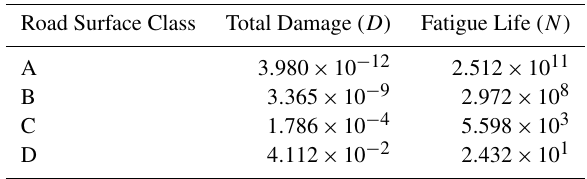
Table 4. Fatigue life of knuckle for various road classes and vehicle speed of 40kmh − 1